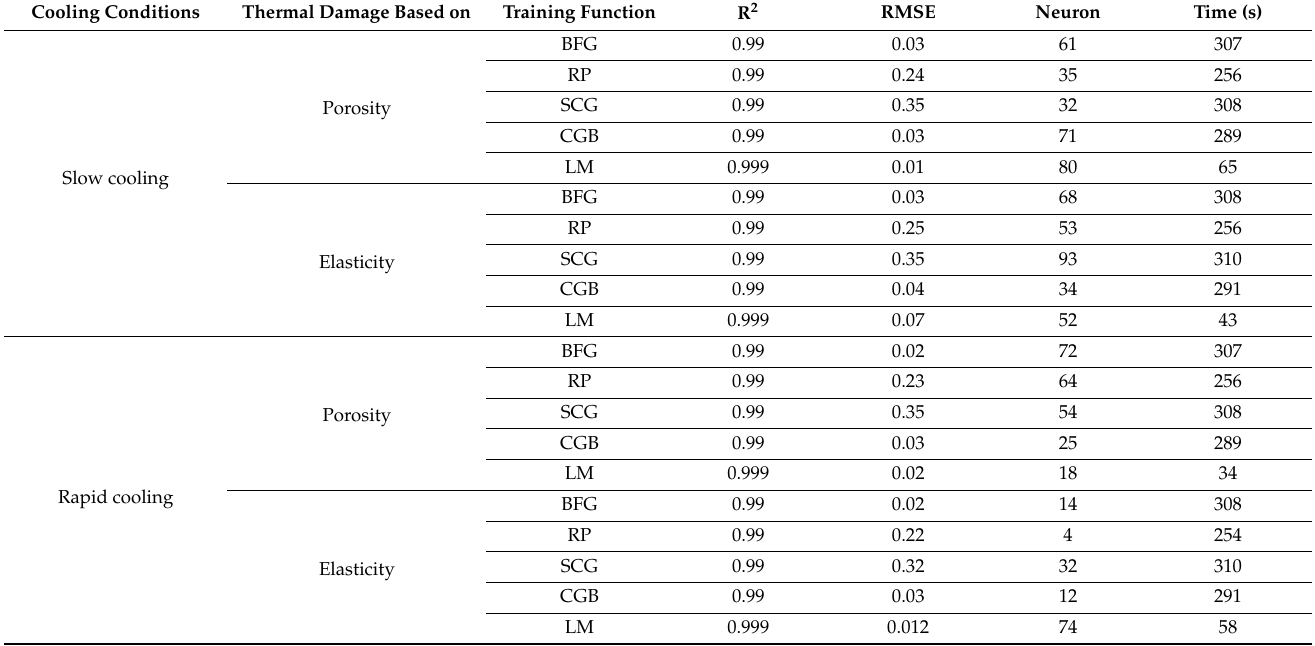
Table 2. Performance evaluation of different training algorithms for D T under both cooling condi- tions.